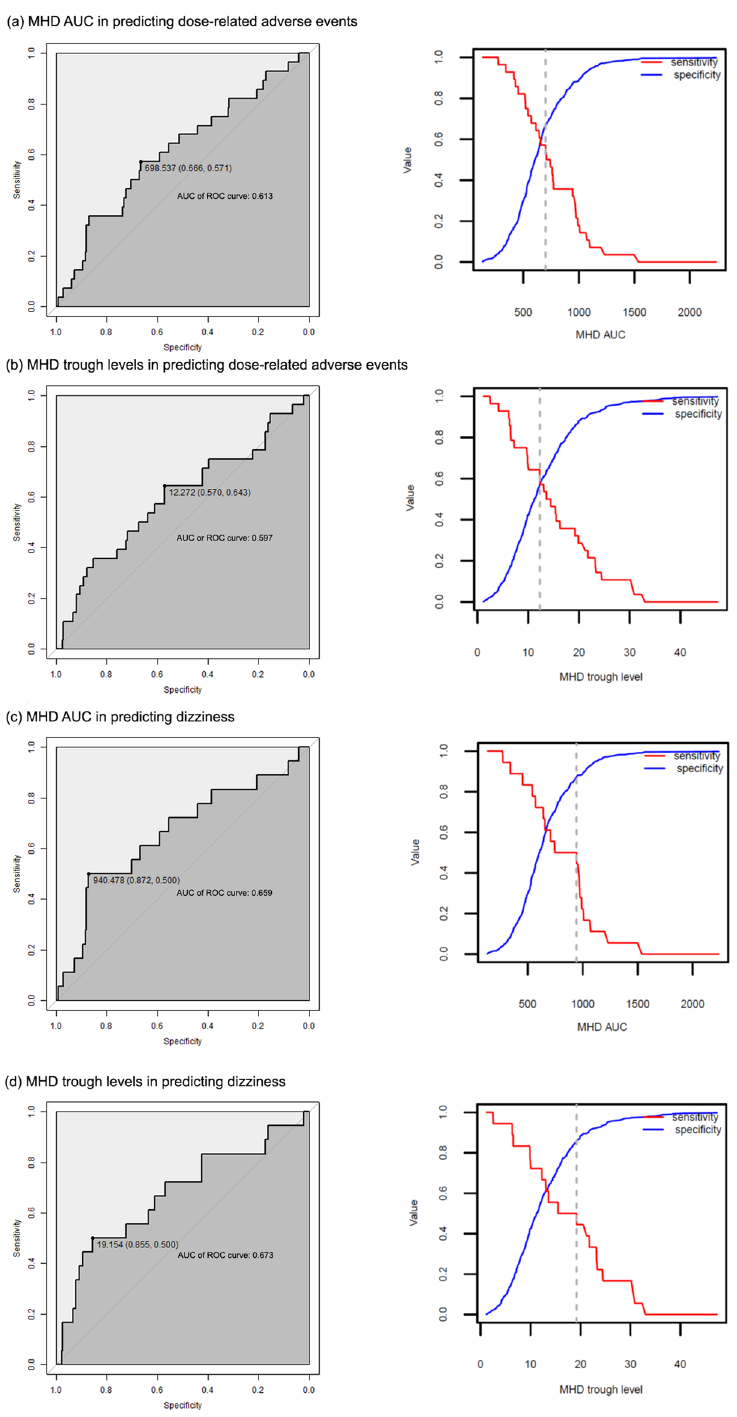
Figure 2. ROC curve for MHD levels in predicting adverse events of oxcarbazepine. ( a ) MHD AUC in predicting dose-related adverse events; ( b ) MHD trough levels in predicting dose-related adverse events; ( c ) MHD AUC in predicting dizziness occurrence; (d) MHD trough levels in predicting dizziness occurrence; ROC, receiver-operator characteristics; AUC, area-under the curve. The data are presented as MHD levels (specificity, sensitivity). Left panels show the ROC curves and right panels show the sensitivity and specificity curve. *AUC represented in each panel is area-under the curve calculated from the ROC curve, not the MHD